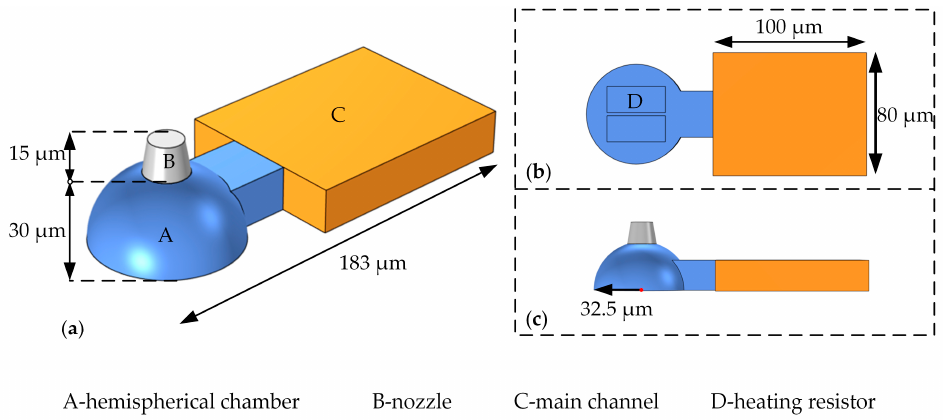
Figure 3. The structural parameters of the hemispherical chamber inkjet head. ( a ) The three- dimensional structure of the hemispherical chamber; ( b ) The side view of the hemispherical chamber; ( c ) The back view of the hemispherical chamber.